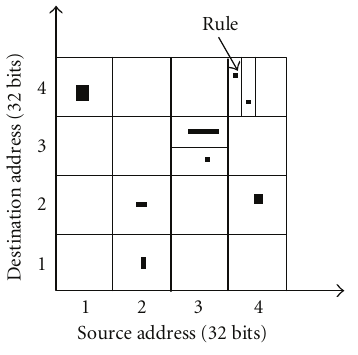
Figure 3: Cutting concept in computational geometry (2- dimensional